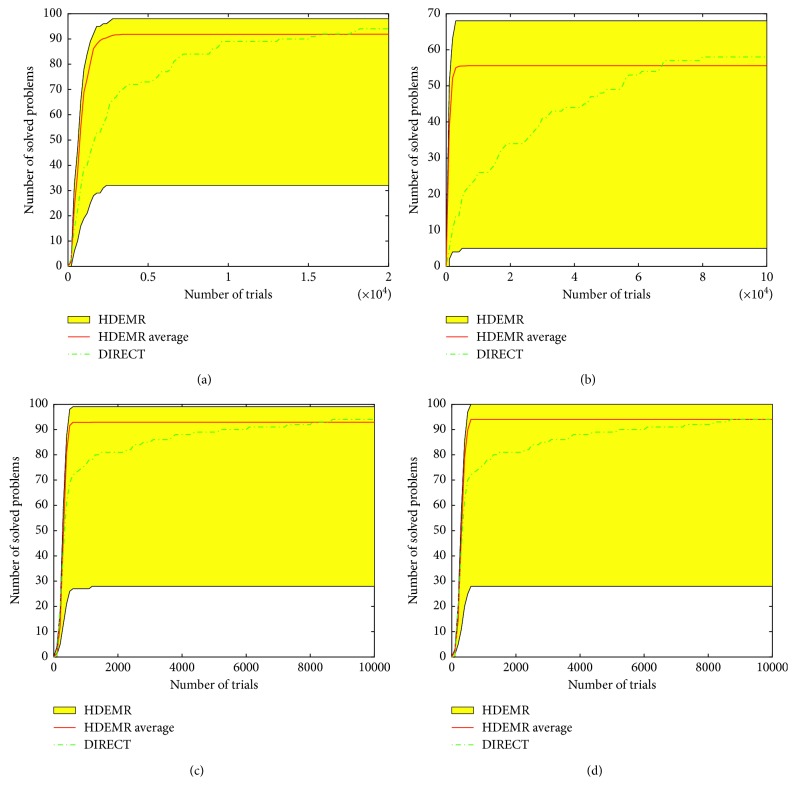
Operational characteristics built on 5- and 10-dimensional classes of GKLS test functions for DIRECT and operational zones for HDEMR. (a) Operational characteristics for DIRECT and the operational zone for HDEMR for the simple 5-dimensional class. (b) The same as (a) for the hard class. (c) Operational characteristics for DIRECT and the operational zone for HDEMR for the simple 10-dimensional class. (d) The same as (c) for the hard class.